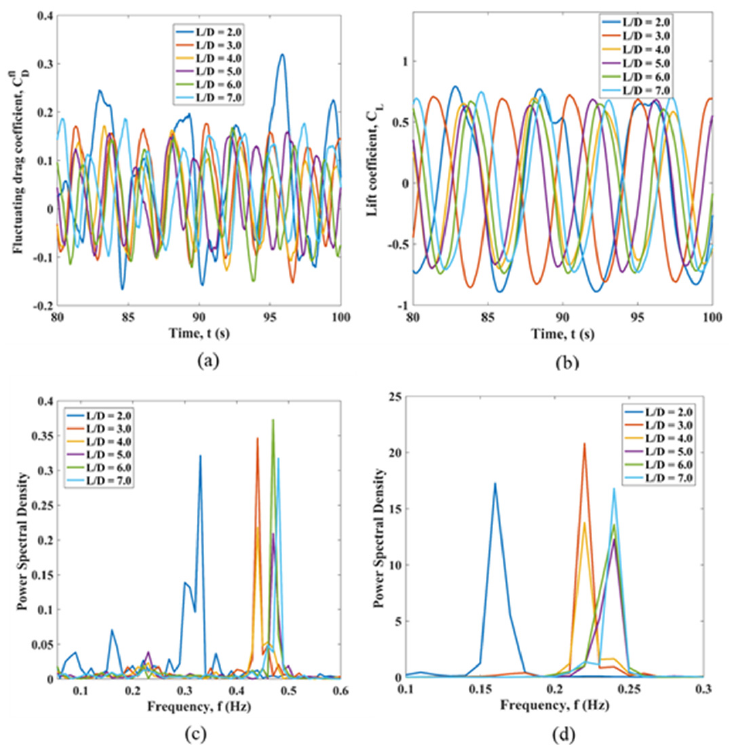
Figure A3. Fluid force coefficients for cylinder 4 immersed in the uniform flow: ( a ) time history of the fluctuating drag coefficient; ( b ) time history of the lift coefficient; ( c ) the drag coefficient FFT; ( d ) the lift coefficient FFT.